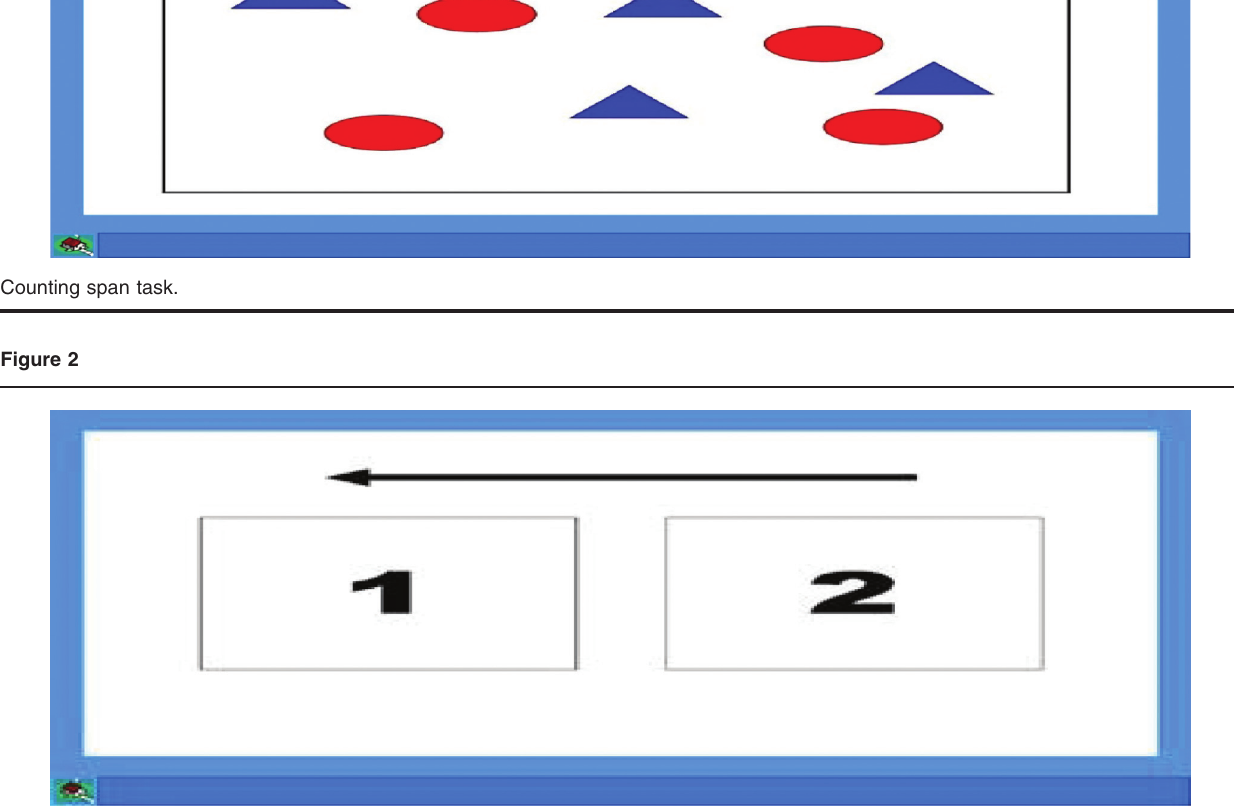
Backward digit span